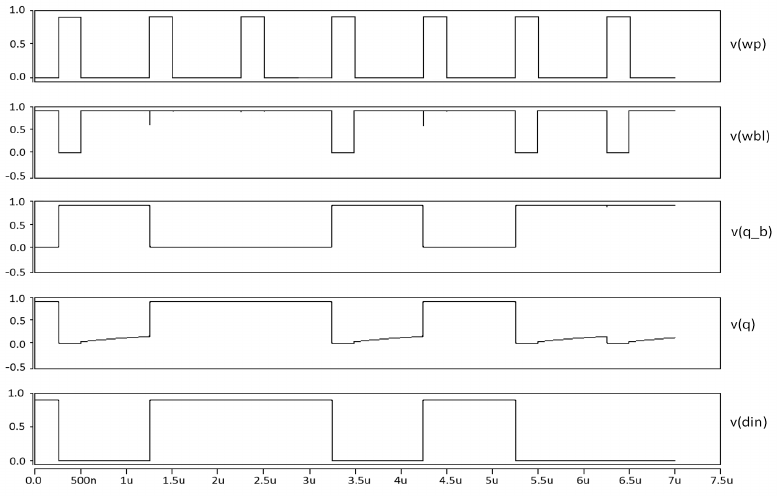
Figure 22. Waveform of write operations in FinFET (Sequence of 0110100).